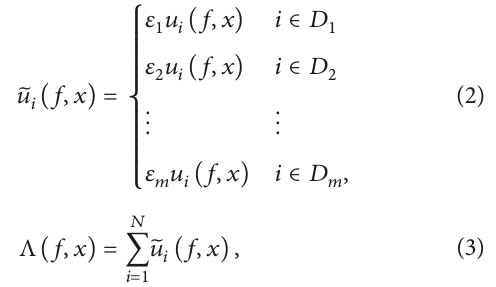
where 𝑠(𝑡) are the input signal and 𝑐 𝑛 (𝑡) are the decomposed IMFs. 𝑟(𝑡) denotes the residual and N is the IMF